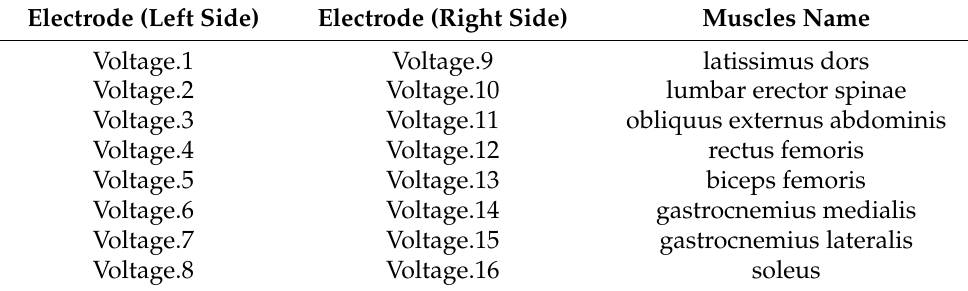
Table 3. Placement of the EMG electrodes during the recording session (see Figure